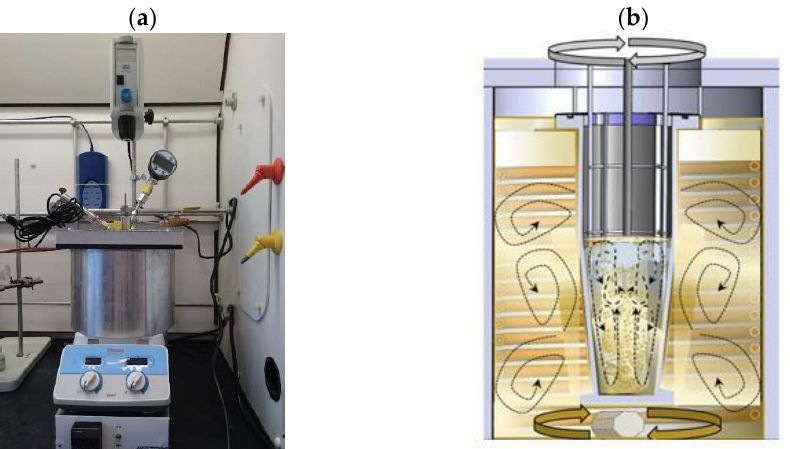
Figure 3. Representation of: ( a ) the CREC VL-Cell apparatus and ( b ) a schematic of the mixing patterns inside the CREC VL-Cell.